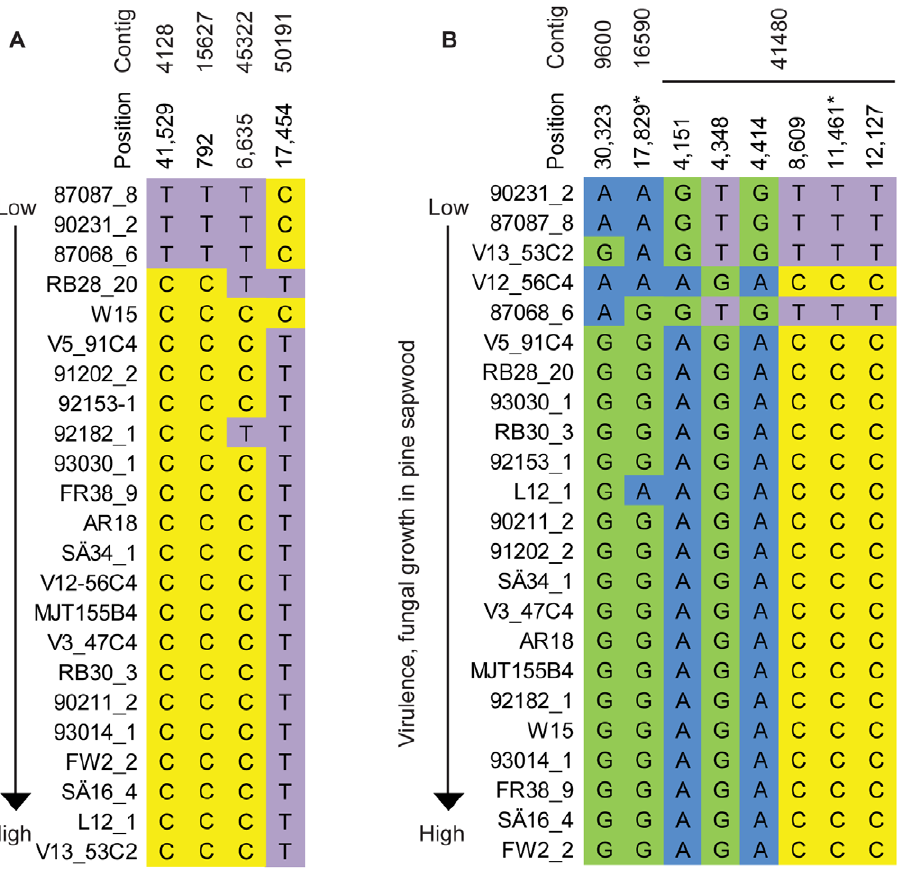
Figure 3. Genotypes for SNPs significantly associated with virulence in spruce and pine. Genotypes for SNPs significantly associated with: (A) fungal growth in spruce sapwood; contig 4128, 15627, 45322, 50191 and (B) fungal growth in pine sapwood; contig 9600, 16590 and 41480. All associations were adjusted by a permutation test, the positions shown have a p adj , 0.0001. Non-synonymous substitutions are labelled with an asterisk.